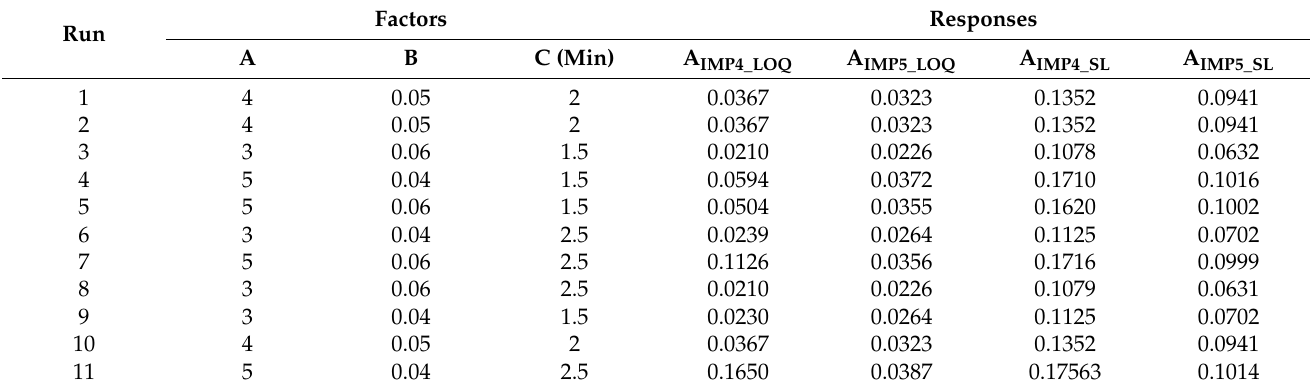
Table 2. Experimental plan proposed by the software and the obtained results for the selected responses.